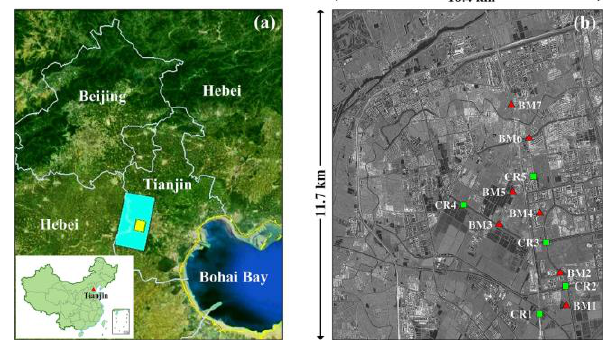
Figure 2. The location map and the study area around Tianjin in China. The coverage of the TSX scenes and the study area selected are marked in (a) by a larger and smaller filled rectangle, respectively. The amplitude image averaged from 40 TSX images of the study area is shown in (b) with annotation of seven BMs by red triangles and five CRs by green